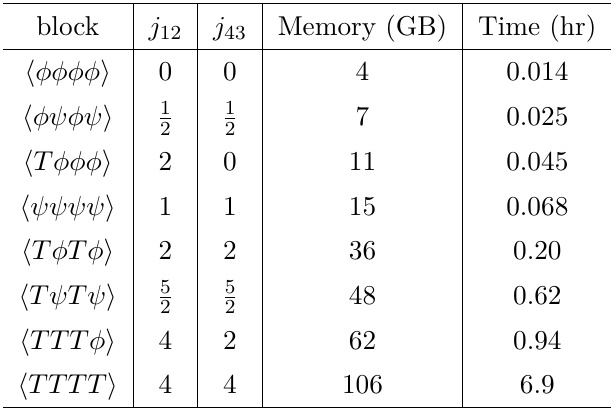
Table 4 : Computing resources required for one call to blocks 3d for each kind of block, using the maximal values of j the parameters in table